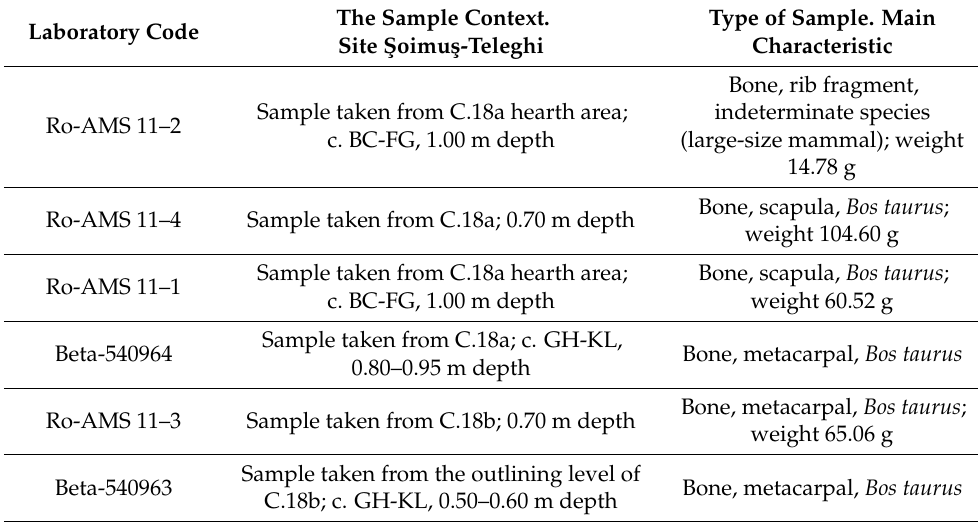
Table 1. Faunal material from S Laboratory Code